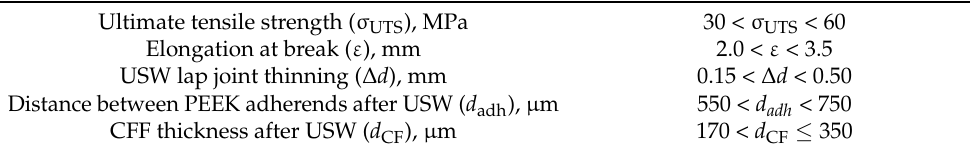
Table 5. Threshold values of the optimal USW lap joint